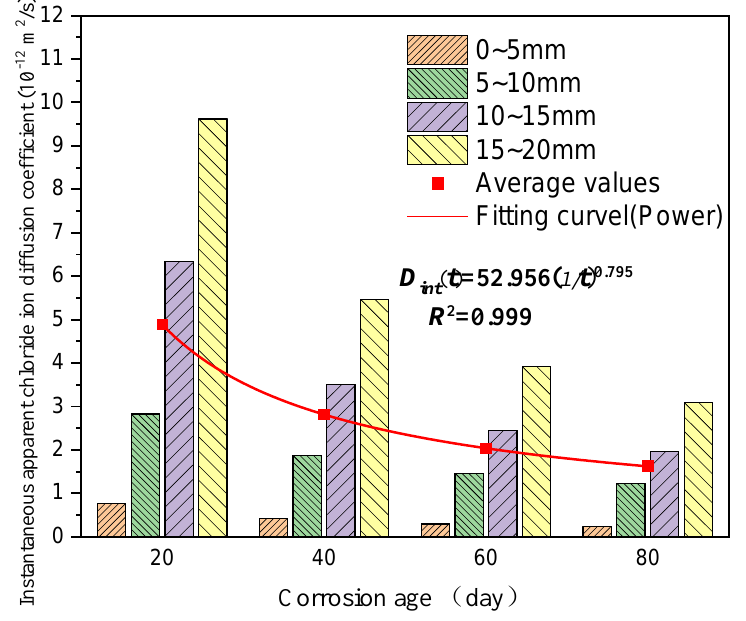
Figure 15. Instantaneous chloride ion diffusion coefficient D ins of SMA-ECC.